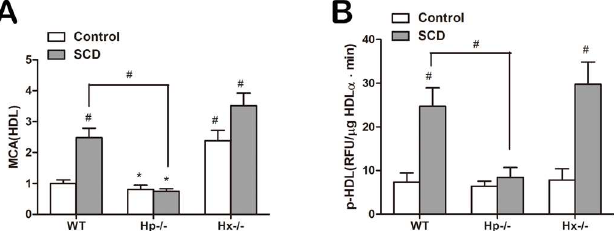
Fig 7. Hb/Hp/Hx complexes play a role in the proinflammatory functions of HDL. HDL was separated from wild-type (WT), Hp − / − and Hx − / − mice either with or without SCD (n = 8 each). (A) The HDL inflammatory index (HII) was measured by monocyte chemotaxis activity (MCA). (B) Proinflammatory HDL (p-HDL) level was measured by plate assay after HDL was isolated by HPLC as previouslydescribed. HII < 1 and lower p-HDL level were only found in the Hp knock-out SCD mice. Comparisons were performed by ANOVA ( * = p < 0.05; # = p <